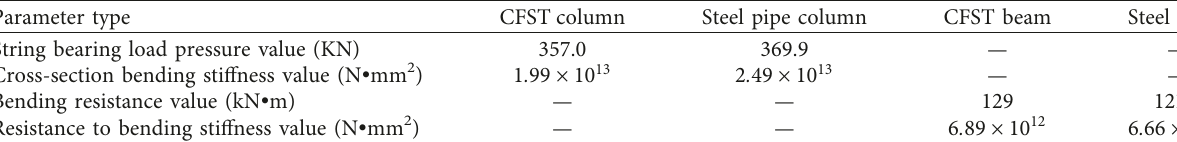
Table 1: Various properties of steel.